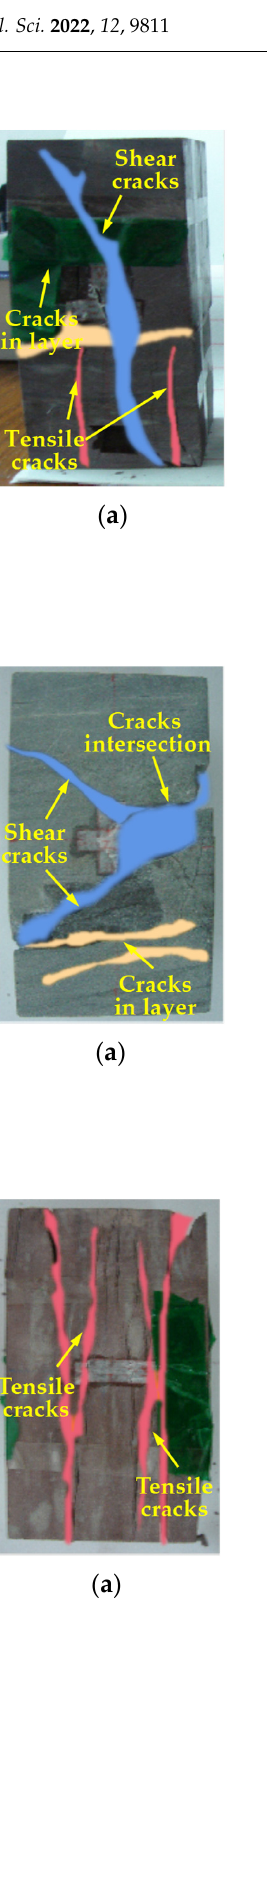
( d ) Figure 11. Fracture distribution of gray samples under parallel loading: ( a ) No. 1 sample; ( b ) No. 2 sample; ( c ) No. 3 sample; ( d ) No. 4 sample.